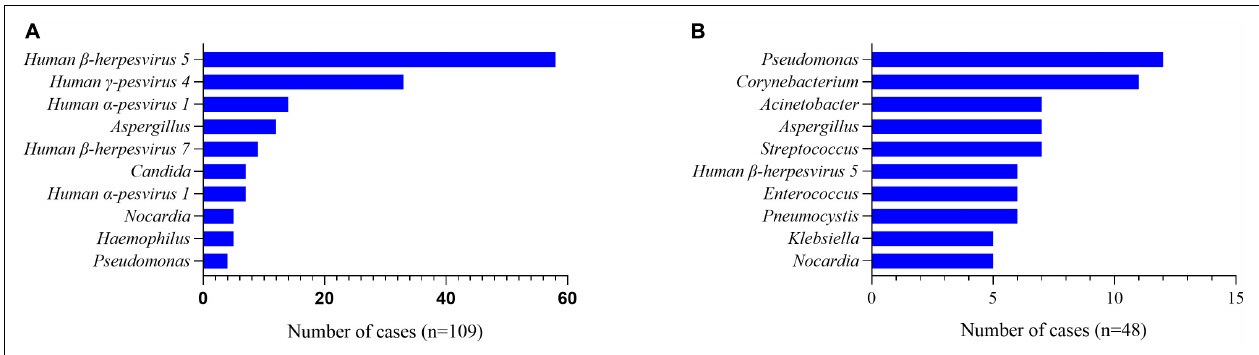
FIGURE 1 | A pathogen spectrum of patients with PJP and non-PJP ones. (A) Co-pathogens in the patients with PJP. (B) Co-pathogens in the non-PJP patients.